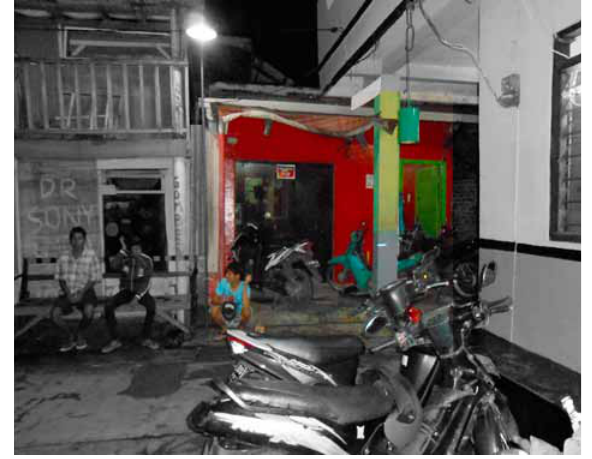
fig. 4. The favourite place to socialize in kampung Keputran Pasar Kecil (the cyber